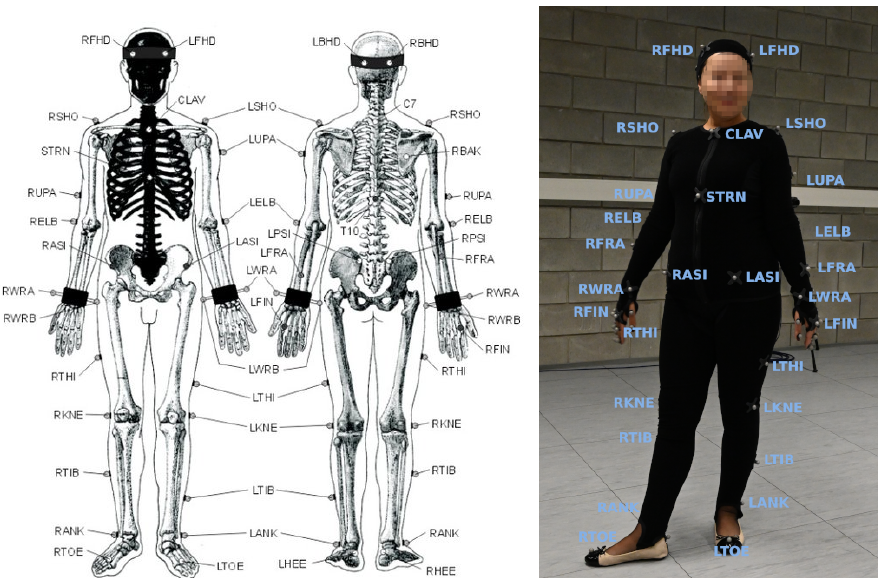
Figure 1. Full body Plug-in Gait marker placement [42] (on the left ) and its real implementation (on the right